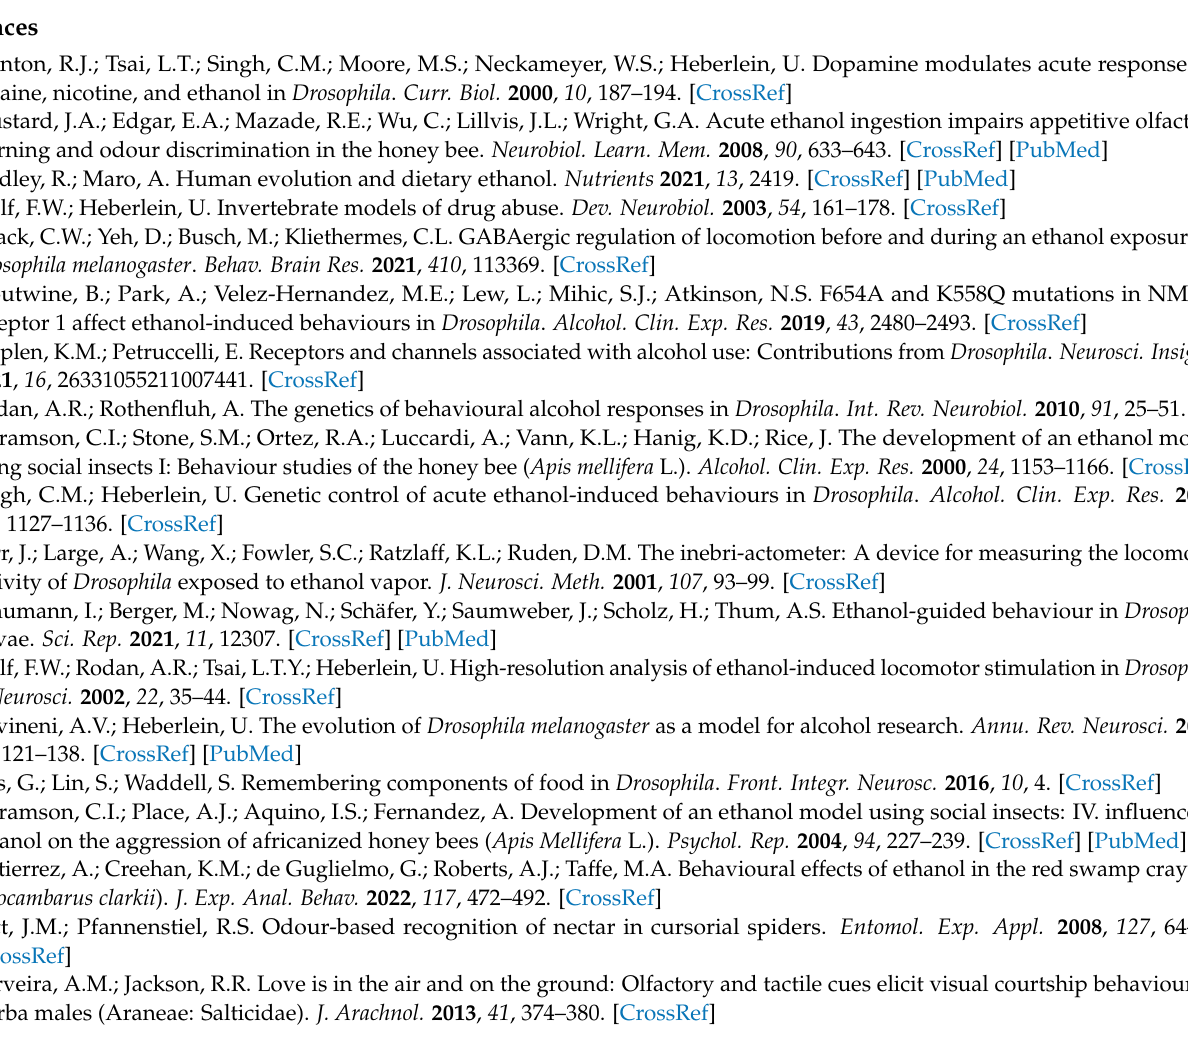
Table S2: The PI (preference index) values and the results from a one-sample t -test for significant differences in PI with 0 of Myrmarachne gisti females.; Table S3: The PI (preference index) values